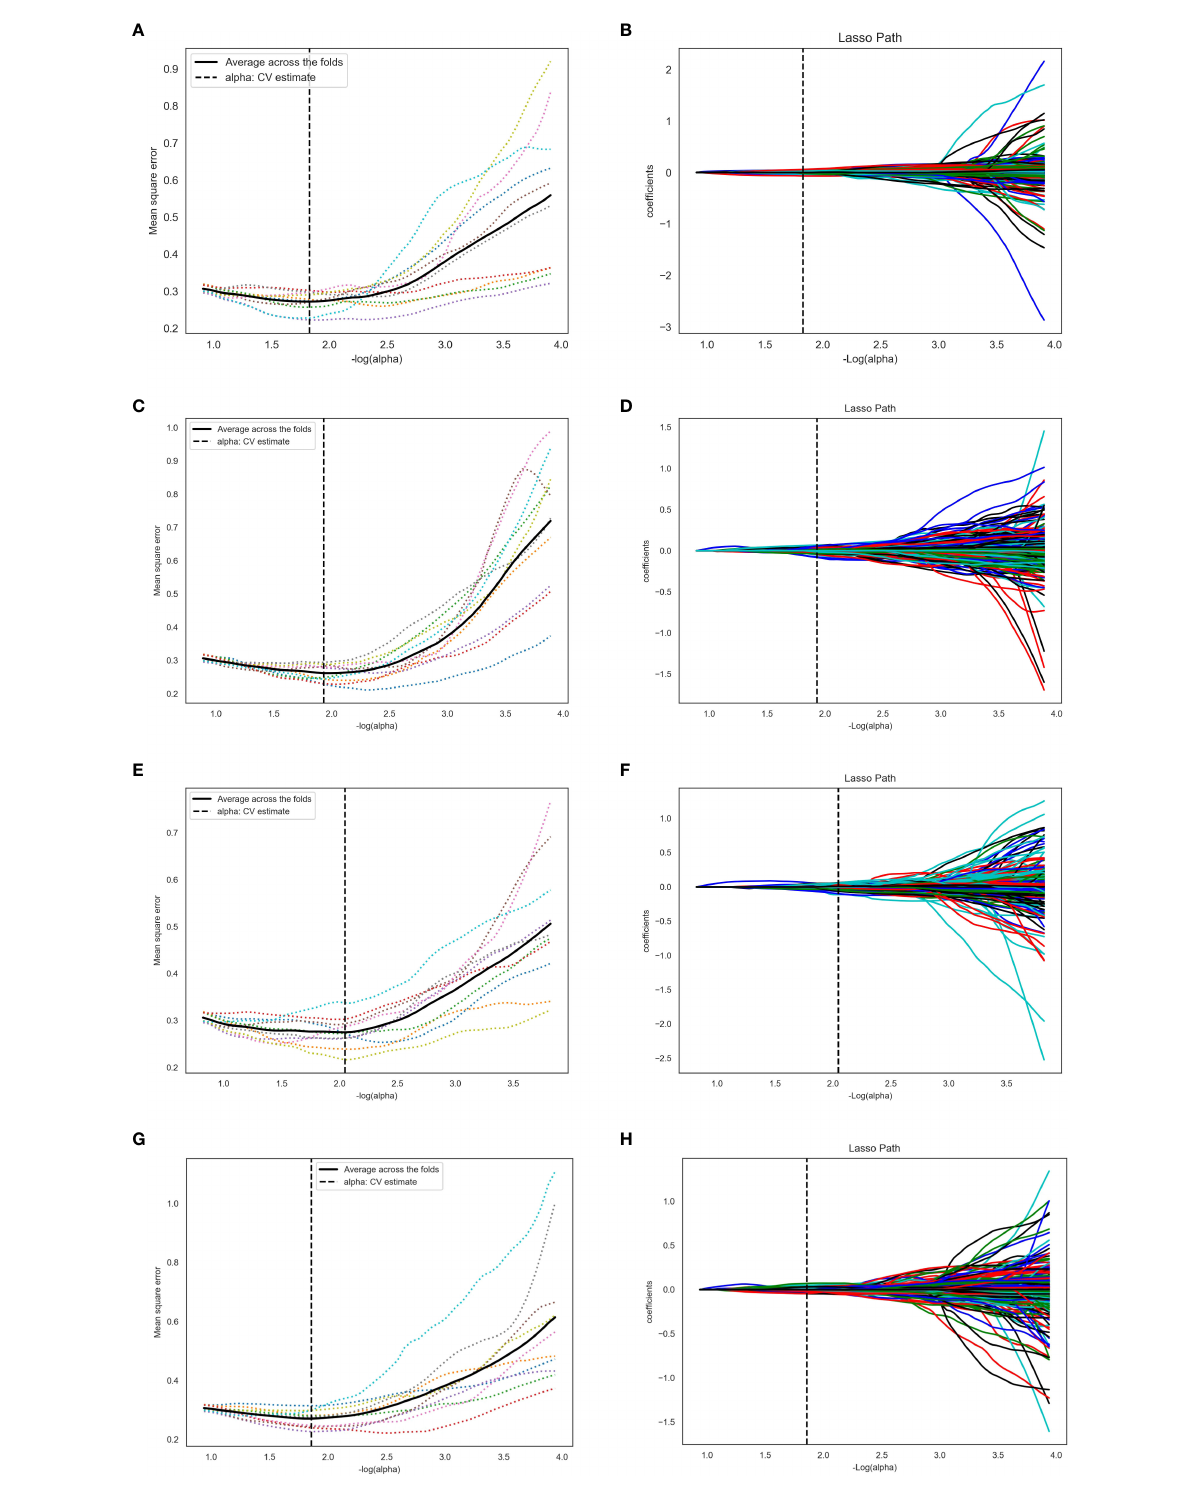
FIGURE 5 The process of Lasso dimension. (A, B) , (C, D) , (E, F) , and (G, H) represent ROI segmentation methods 1, 2, 3, and 4, respectively. For method 1, log(alpha) was 1.827 and alpha was 0.0149. For method 2, log(alpha) was 1.931 and alpha was 0.0117. For method 3, log(alpha) was 2.047 and alpha was 0.0089. For method 4, log(alpha) was 1.857 and alpha was